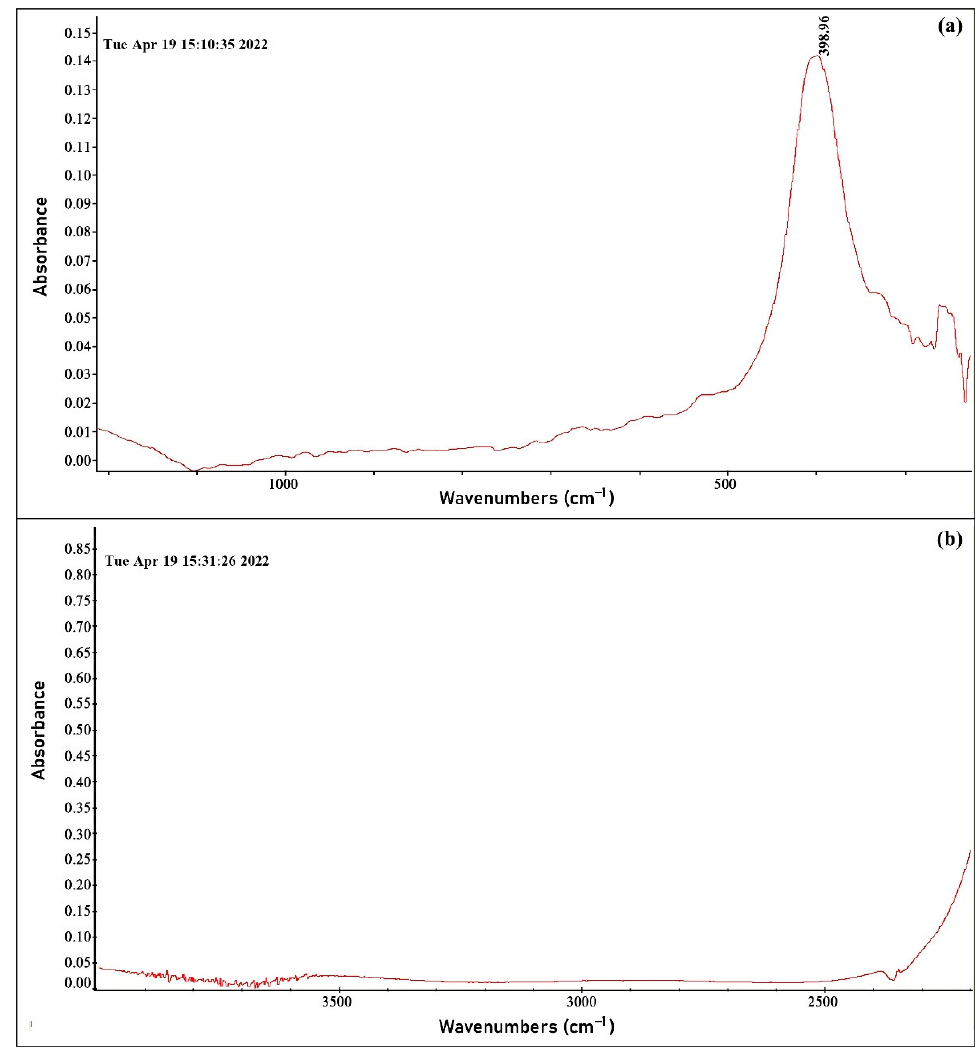
Figure 9. FTIR spectrum of the ZnO<La> film in the wavenumber range of ( a ) 1100–230 cm −1 and ( b ) 4000–2300 cm −1